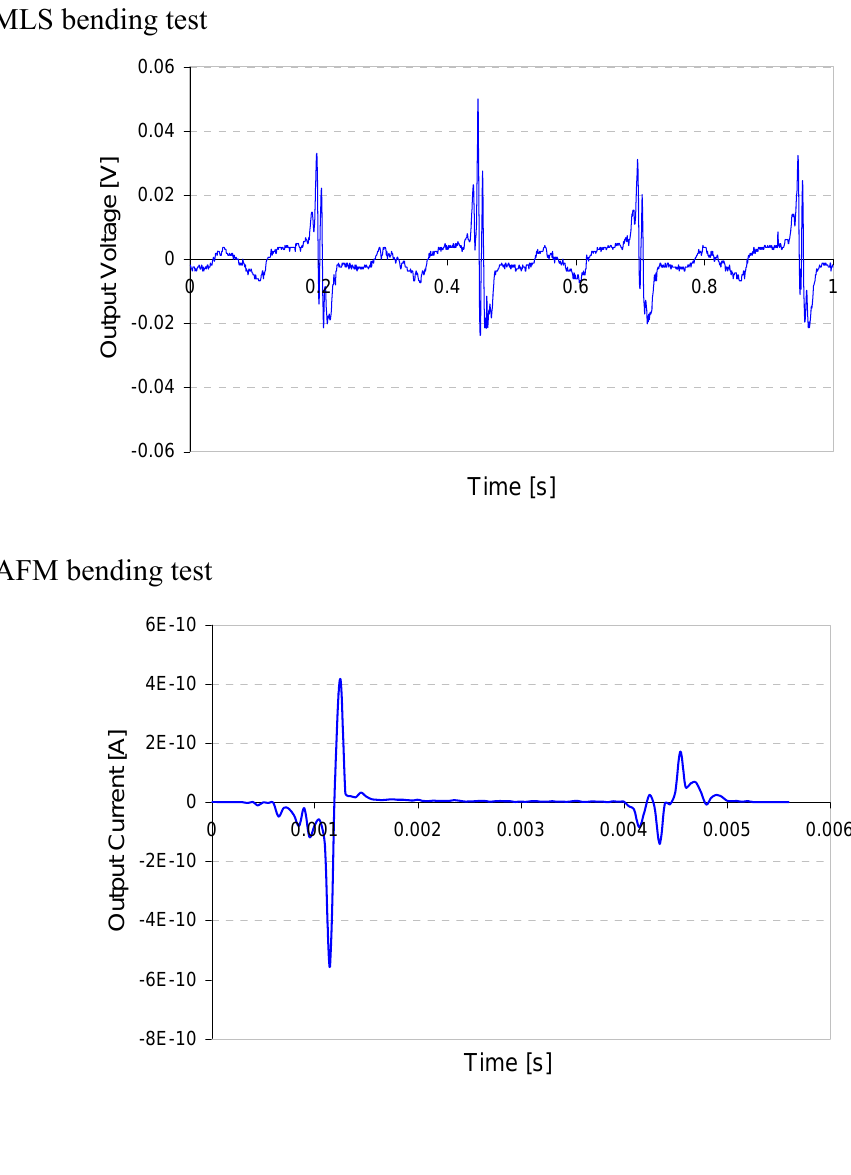
Figure 7. The results of (a) Motorized Linear Stage (MLS) and (b) AFM tests showing the output have similar behavior at different scales. The MLS test was to fix two ends of the sensor while the AFM was on a sensor that was fixed at one end only with manual